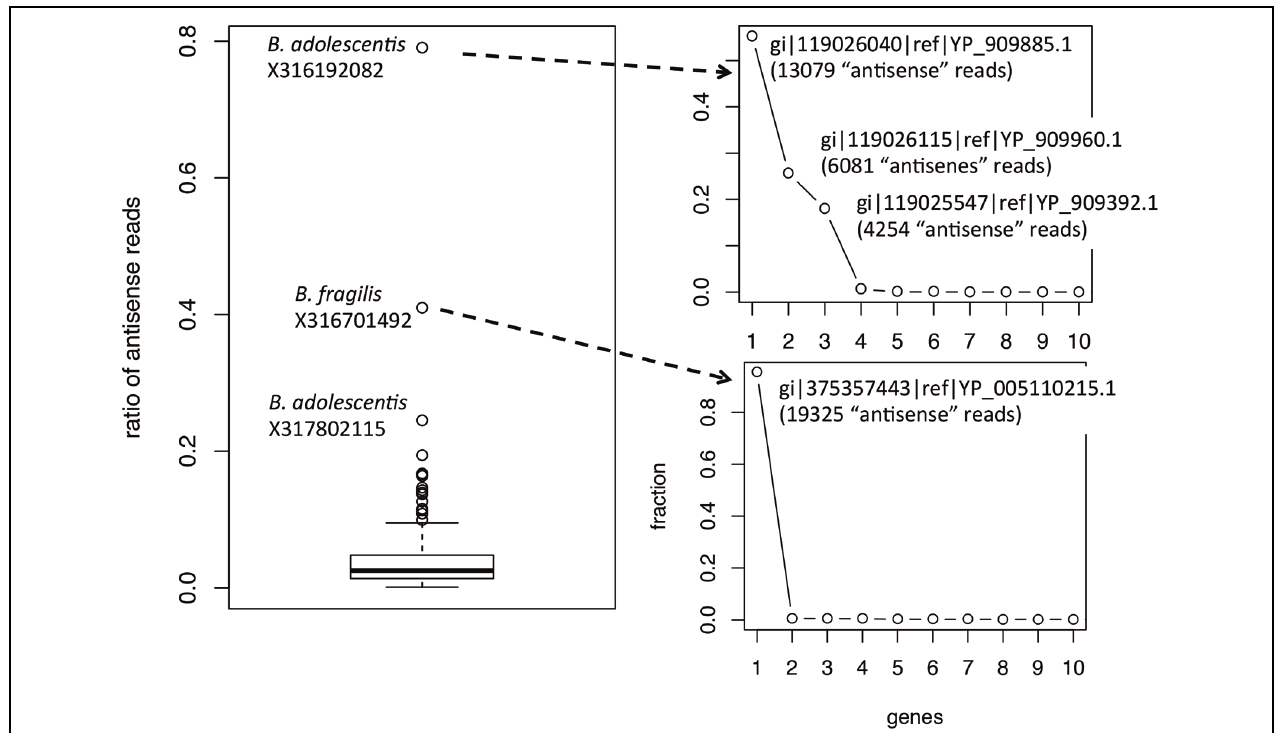
FIGURE 3 | Boxplot of the ratios of antisense reads (left). The plots on the right show the contribution of individual genes to the total antisense reads for the two outliers B. adolescentis and B. fragilis . Most of the antisense reads came from three and one genes (likely misannotations) for B. adolescentis and B. fragilis ,